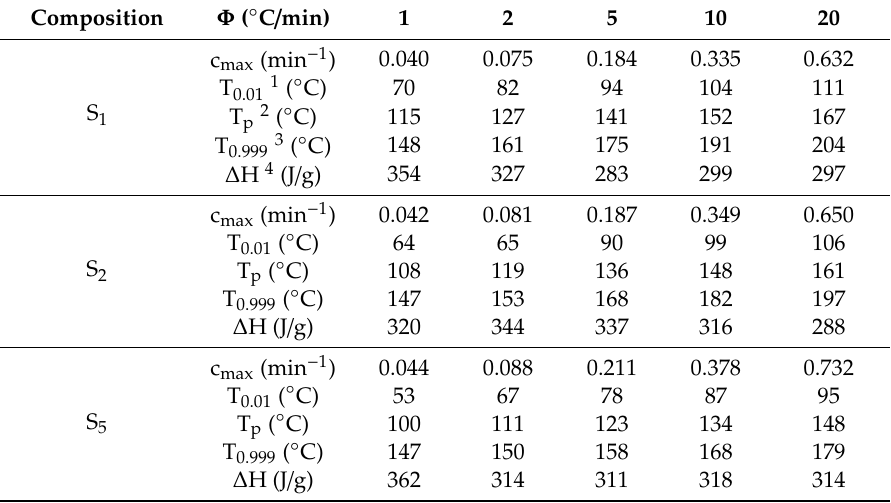
Table 4. Cure parameters of benchmark compounds computed from DSC scans.